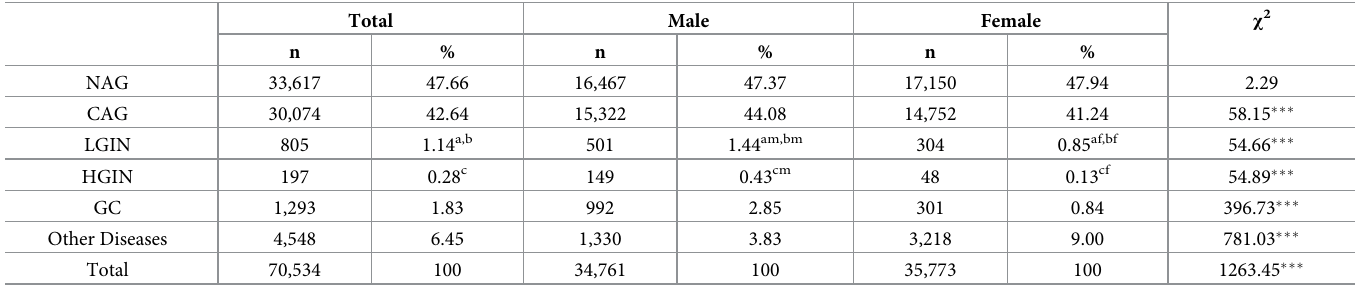
Table 1. Differences in distribution of 70,534 gastroscopic biopsied patients between males and